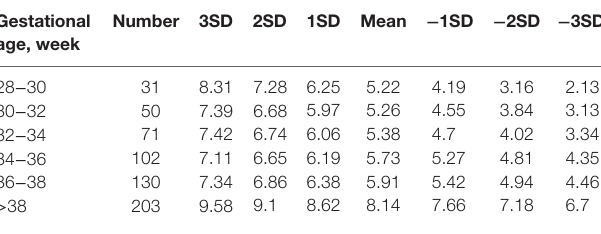
TaBle 2 | SD of penile circumference (PC) based on different gestational age of the study neonates. gestational age, week